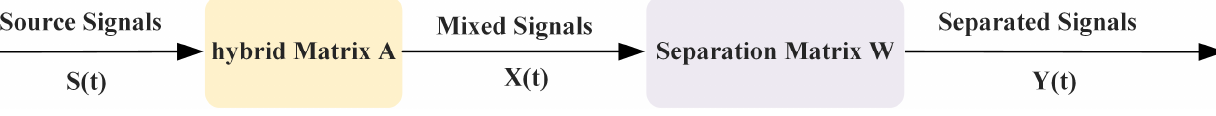
Figure 1. BSS modeling flow